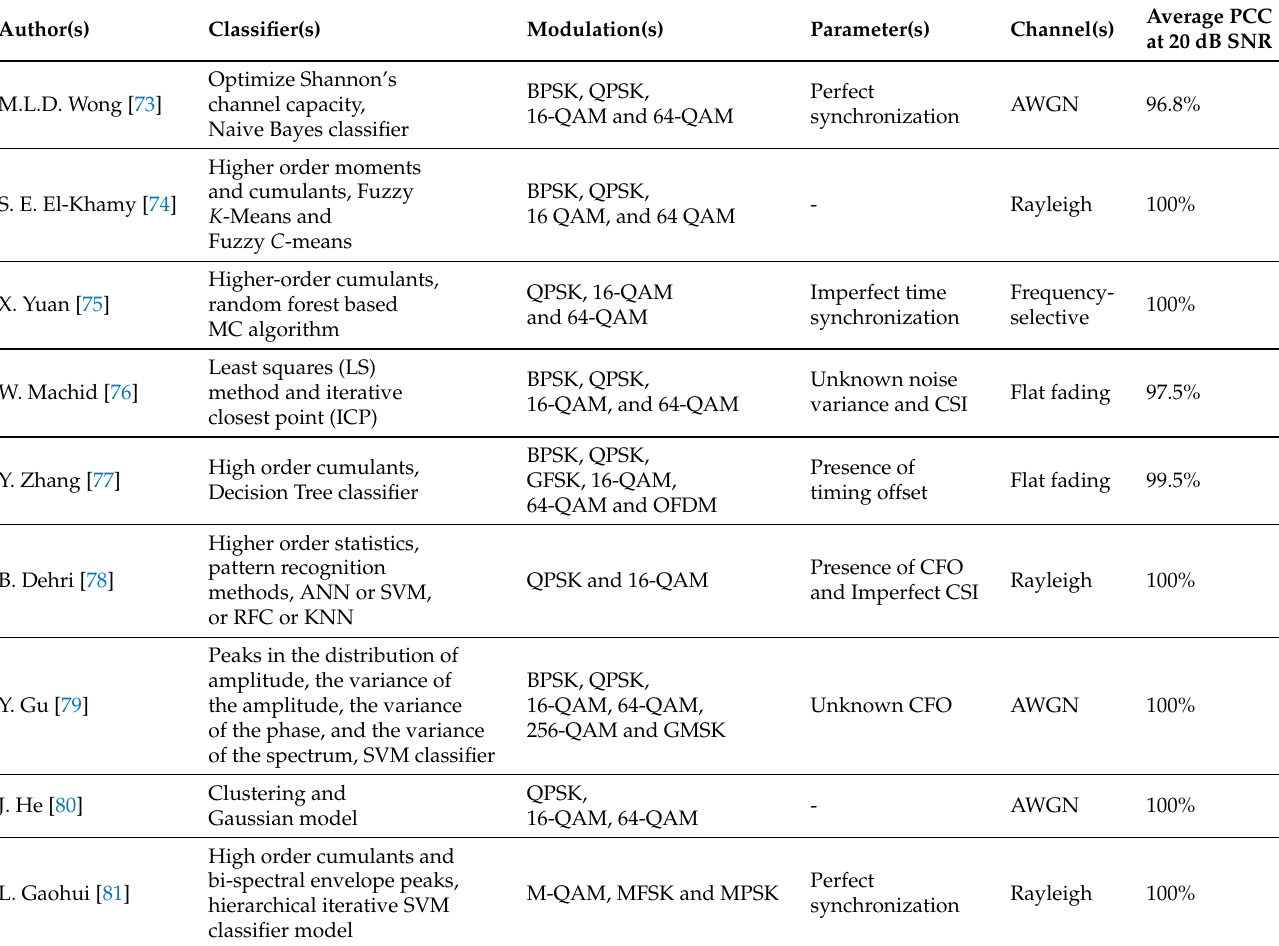
Table 5. Summary of ML-based classifiers for OFDM